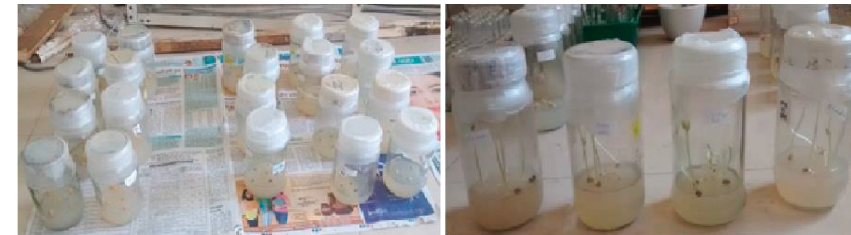
Figure 2: Inoculation of pulses seeds on 1st day and Growth after 14th